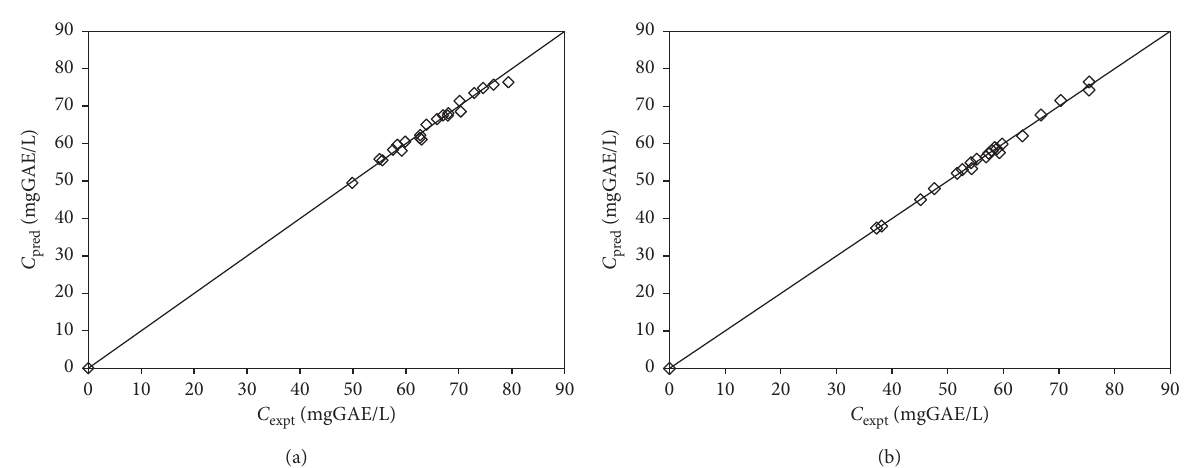
Figure 3: Correlation between experimental versus predicted values for concentrations TPC obtained using Peleg model for different temperatures (a) and solvent compositions (b).